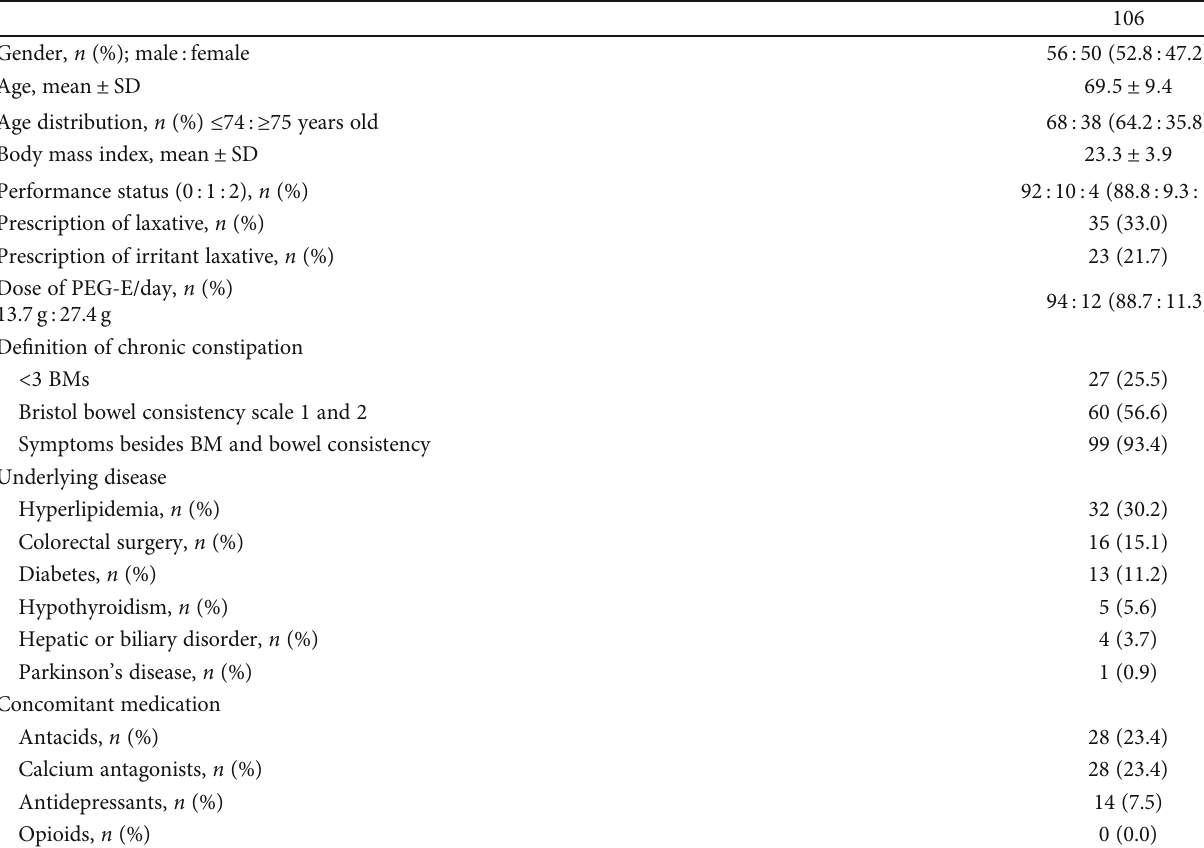
Table 1: Patients ’ characteristics.